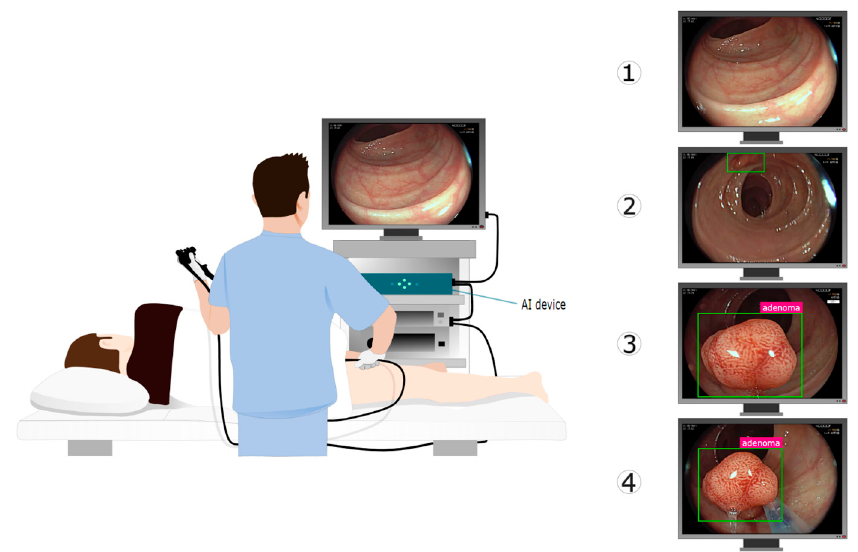
Figure 1. GI Genius is an intelligent endoscopy module designed to be an adjunct to video colonoscopy, to support the operating physician with AI during the colonoscopy. GI Genius augments the video stream by adding graphical overlay markers surrounding areas of interest. As a result, they can be further inspected and assessed independently according to established clinical practice. On the right side, the sequence of actions during a colonoscopy with the assistance of an AI device is depicted: ( 1 ) endoscope navigation through the colon; ( 2 ) polyp detection (CADe); ( 3 ) polyp characterization (CADx); and ( 4 ) polyp resection. Illustration from Bi ffi et al. [19].